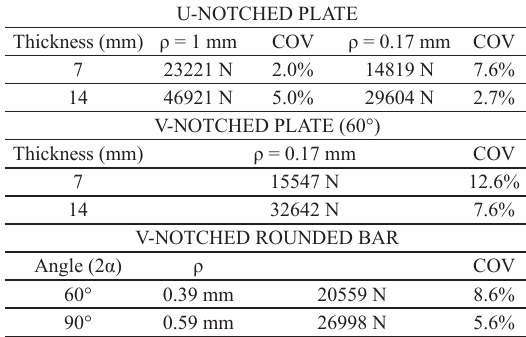
Table 5. Average load-bearing capacity of the tested specimens. U-NOTCHED